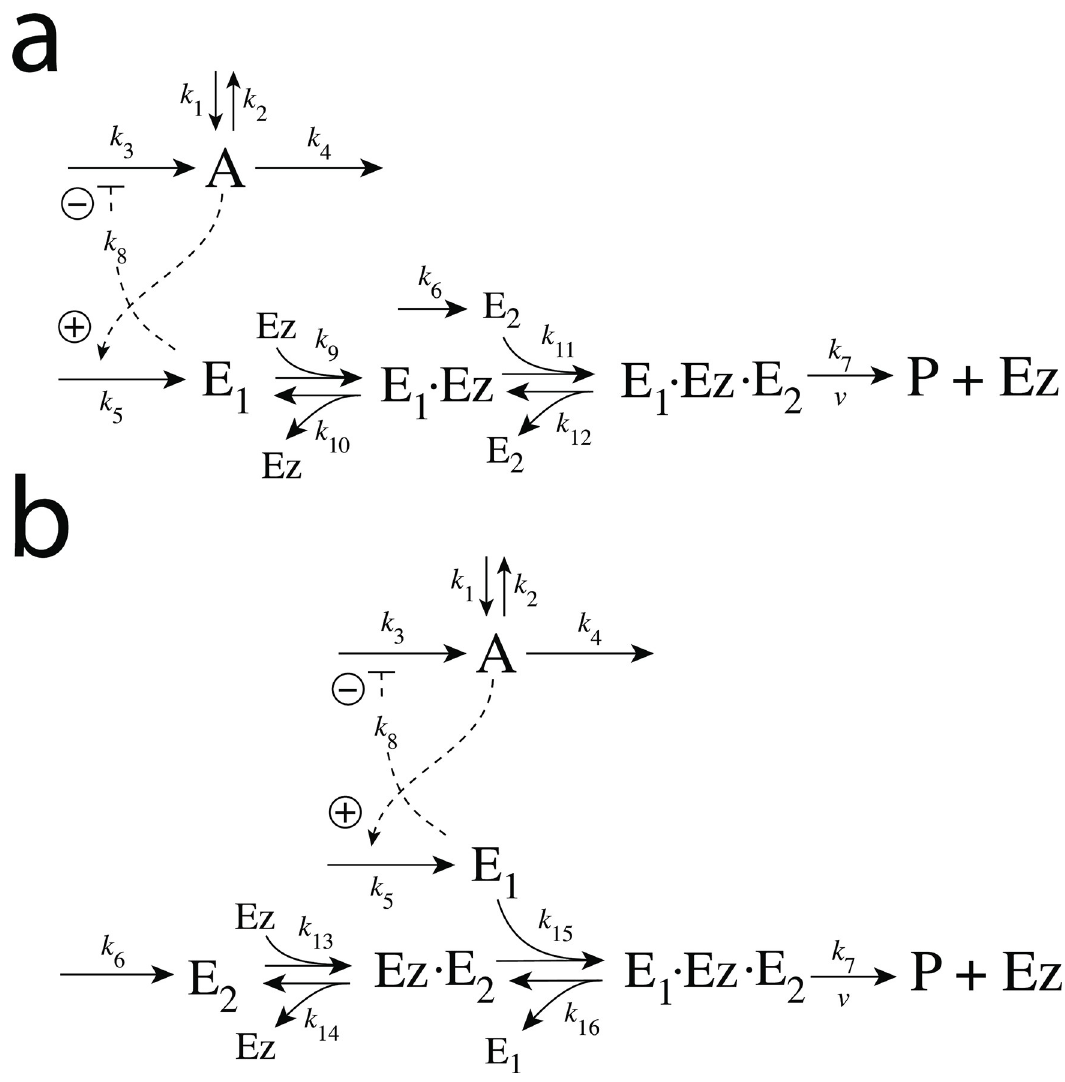
Fig 11. Motif 2 dual-E controller when E 1 and E 2 are removed enzymatically by compulsory-order ternary-complex mechanisms. Panel a: E 1 binds first to free enzyme Ez. Panel b: E 2 binding first to